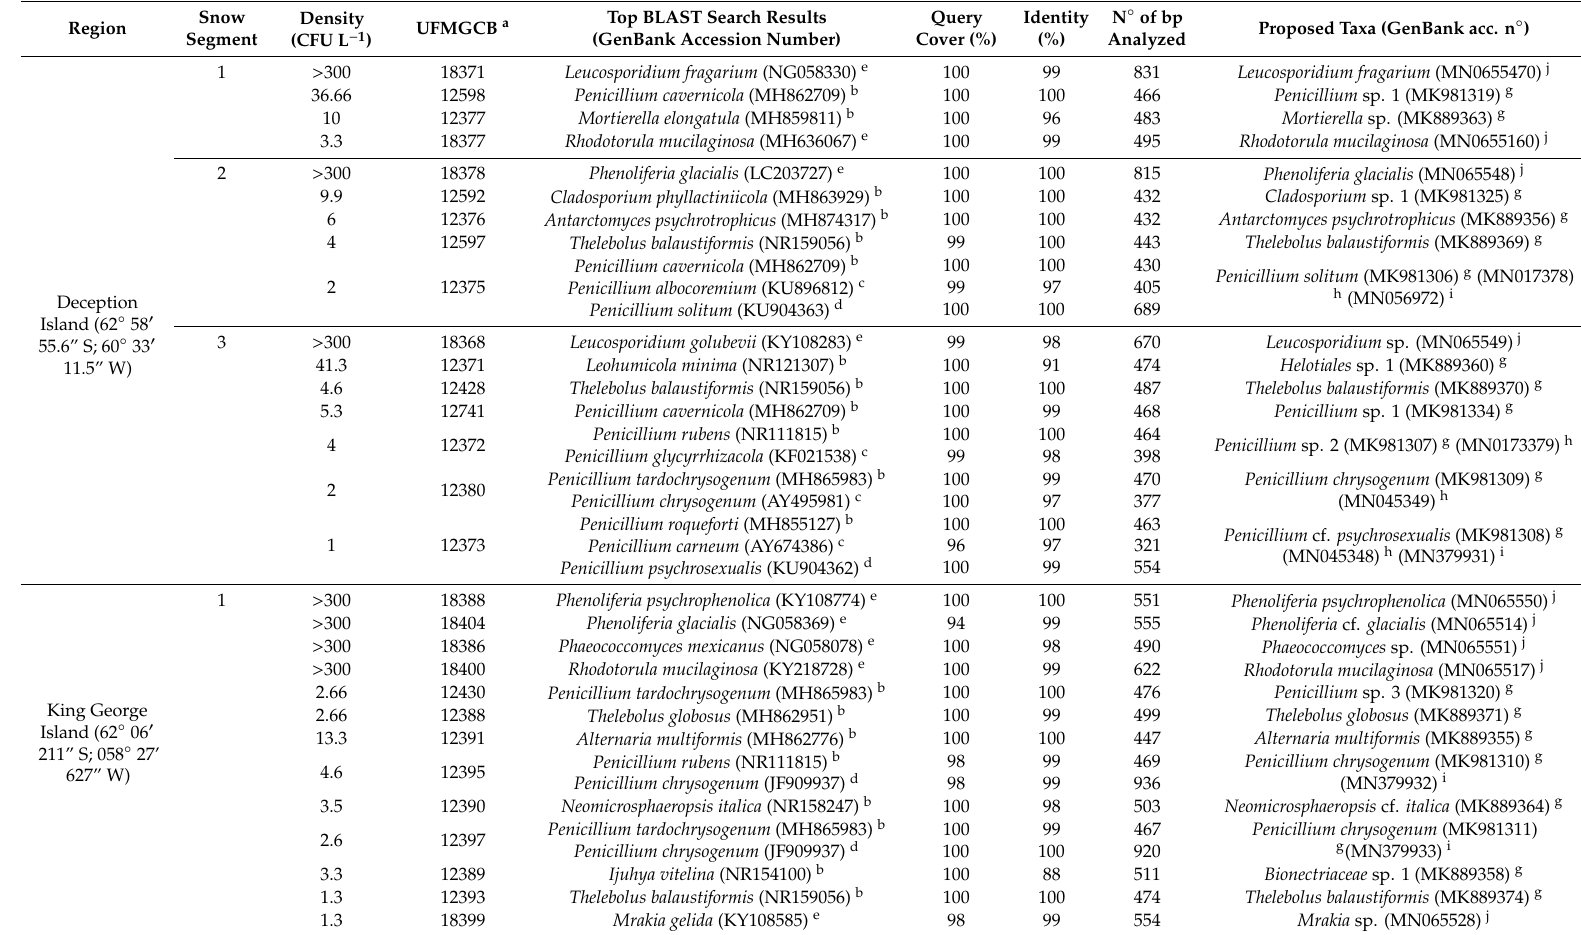
Query Identity N ◦ of bp Proposed Taxa (GenBank acc. n ◦ Cover (%) (%) Analyzed